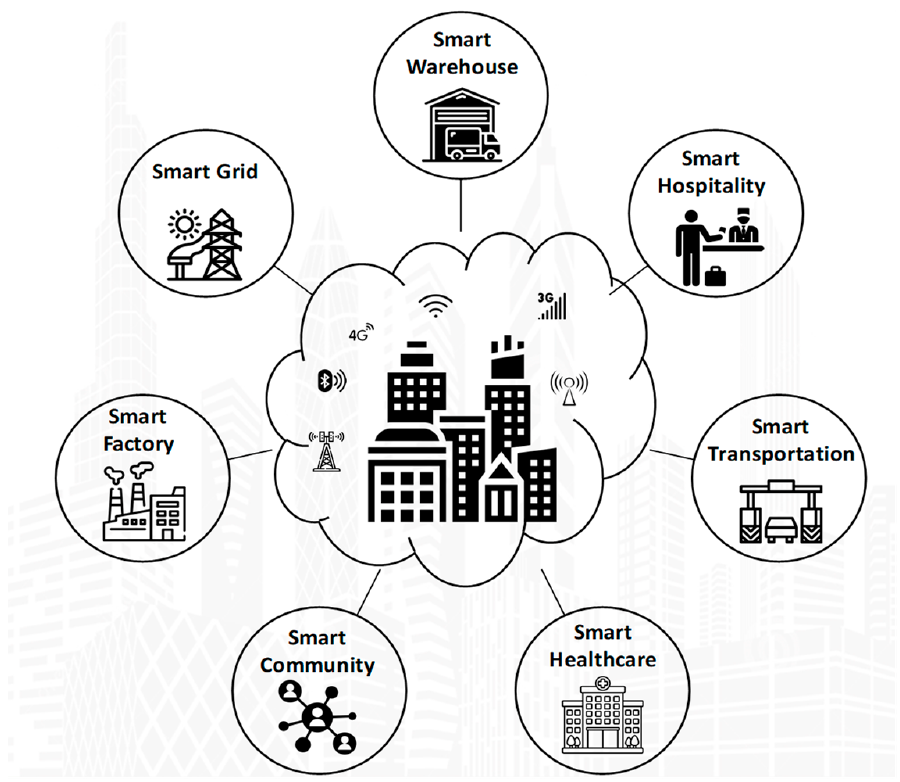
Figure 11. Generic composition of smart city architecture.